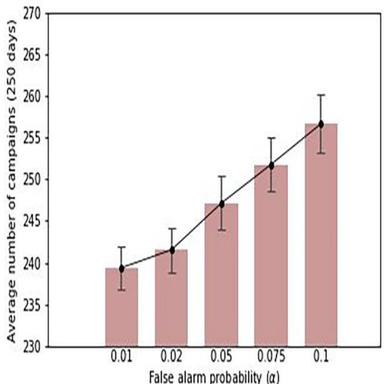
2. With the false alarm probability of 0.01, the average number of campaigns is 239 ± 2.6. The following average numbers of campaigns given the false alarm probabilities of 0.02, 0.05, 0.075, and 0.1 are 242 ± 2.7, 247 ± 3.2, 252 ± 3.3, and 257 ± 3.5.